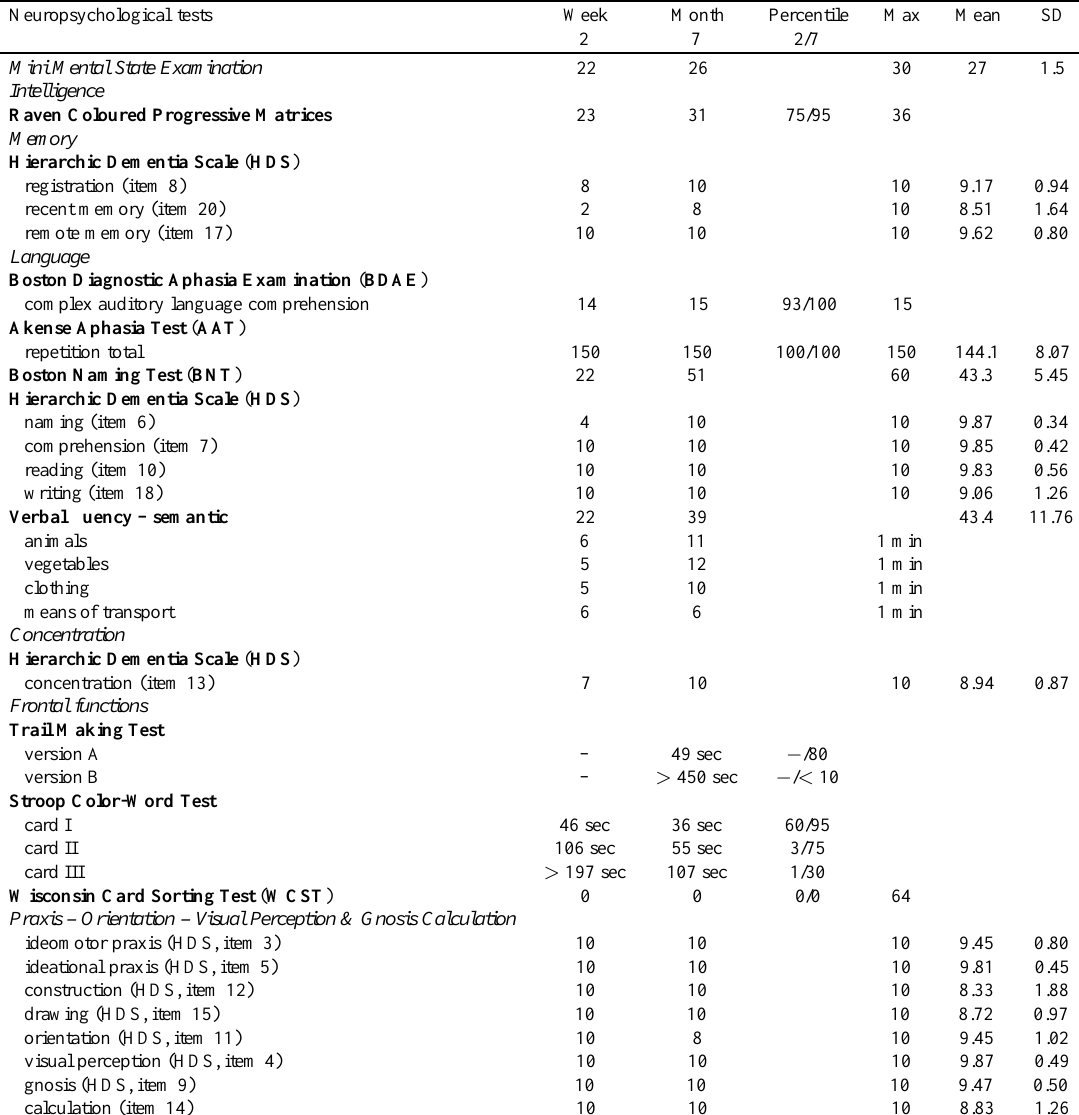
Table 1 Neuropsychological test results obtained two weeks and seven months